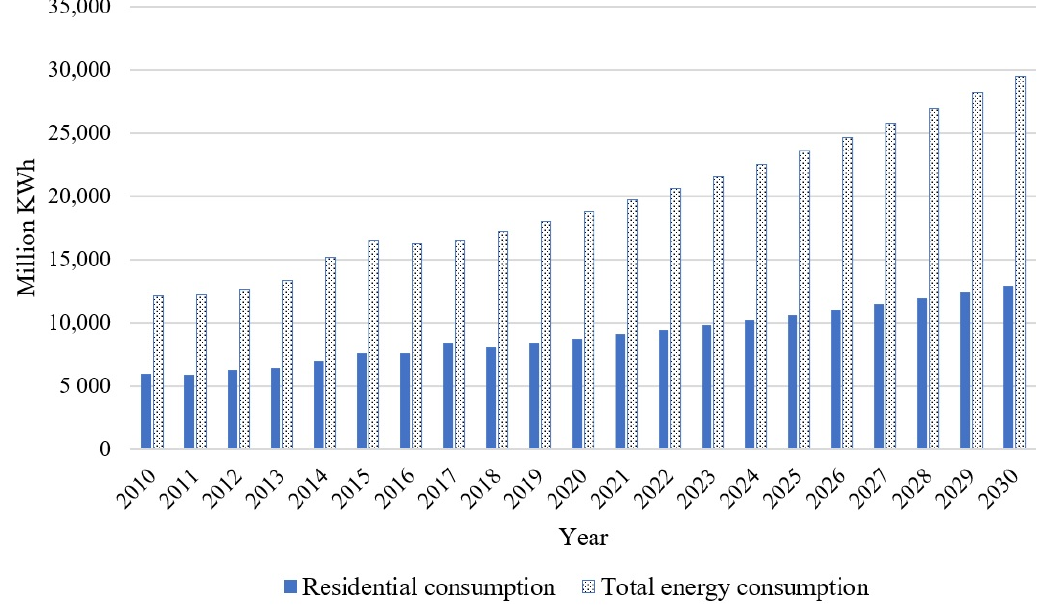
Figure 6. Energy consumption forecast for Bahrain’s residential sector in relation to total energy consumption.